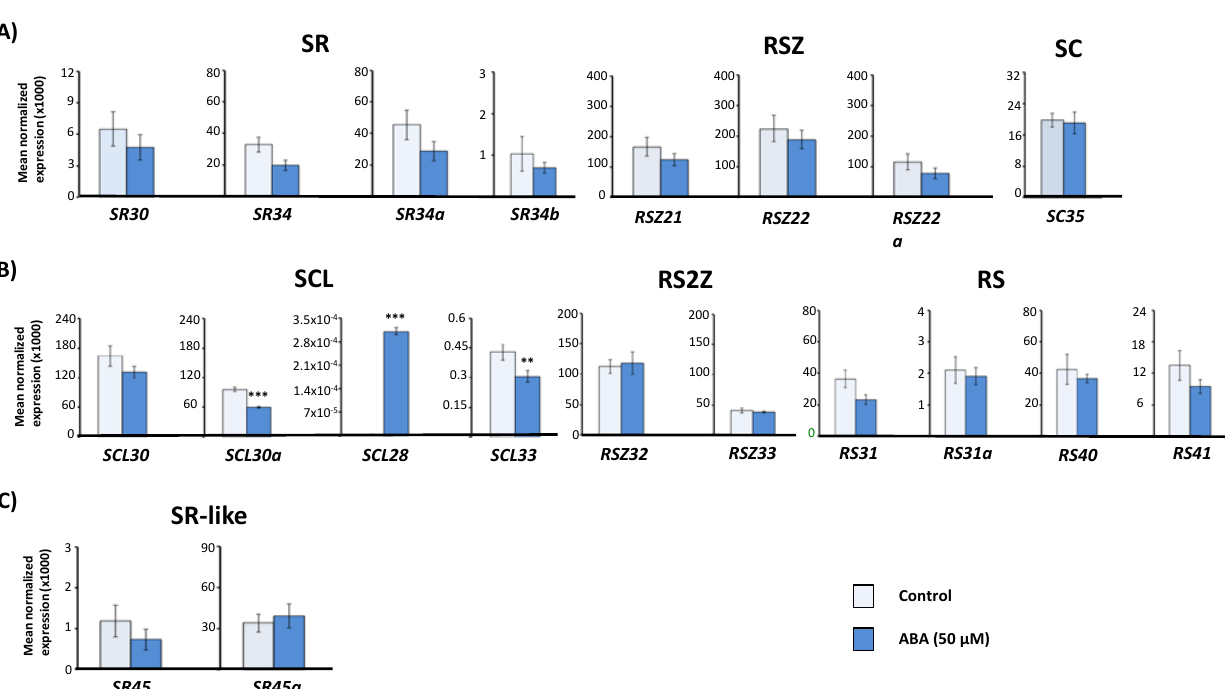
Figure 2. Effect of ABA treatment on the expression of Arabidopsis serine/arginine-rich (SR) and SR-like genes. Real-time RT-qPCR analysis of total transcript levels of SR gene members of the mammalian ortholog ( A ) and plant-specific ( B ) subfamilies or of SR-like genes ( C ) in control and ABA-treated (50 µM for 5 h) wild-type (Col-0) Arabidopsis seedlings. Results are from two independent experiments and values represent means ± SE ( n = 4). Asterisks indicate significant differences (** p < 0.01, *** p < 0.001; Student’s t -test) from the corresponding wild